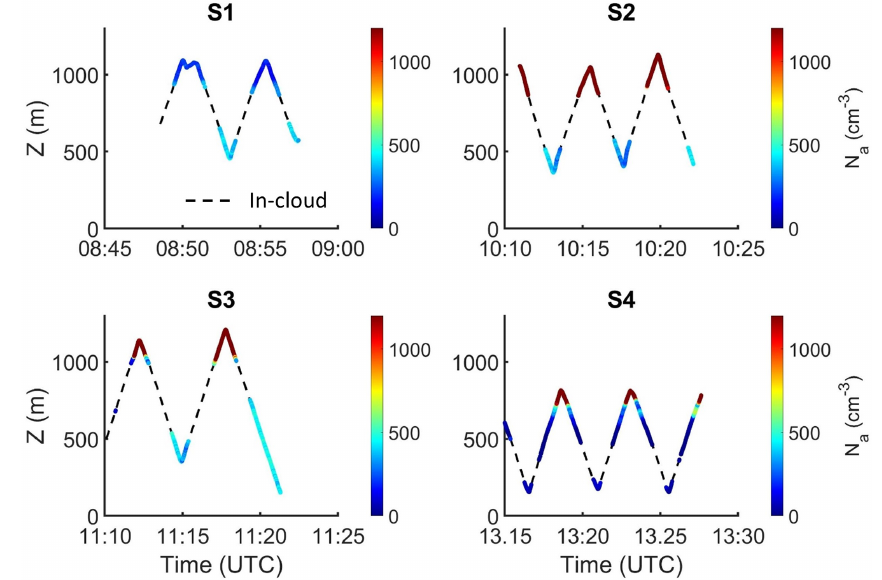
Figure 3. P-3 aircraft altitude as a function of time, colored by PCASP accumulation mode (0.1 <D < 3µm) N a for four sawtooth maneuvers flown on 6 September 2016. In-cloud N a are masked due to potential for droplet shattering on the PCASP probe inlet.